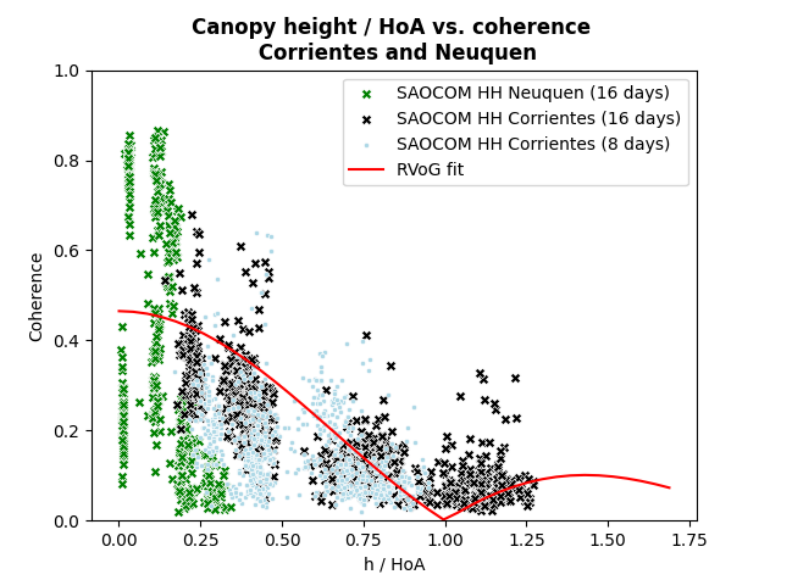
Figure 19. Ratio of GEDI Canopy Height and Z 2 π ( h / HoA ) vs. | γ | in Corrientes and Neuquen